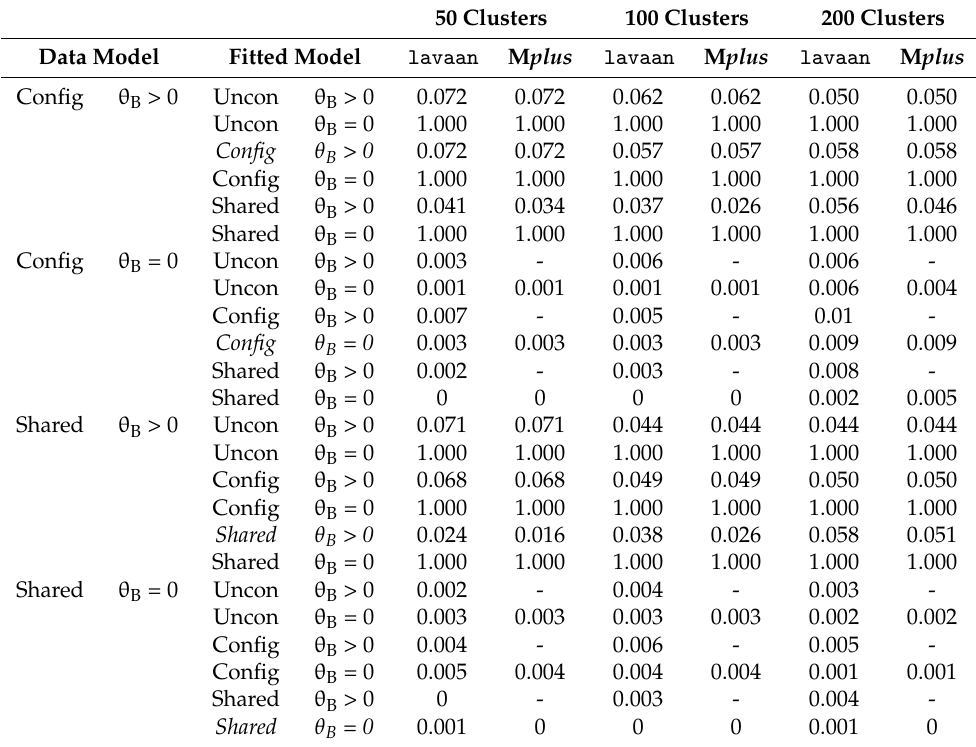
Table 4. Rejection rates of the χ 2 test at α = 0.05 with ML estimation using QN